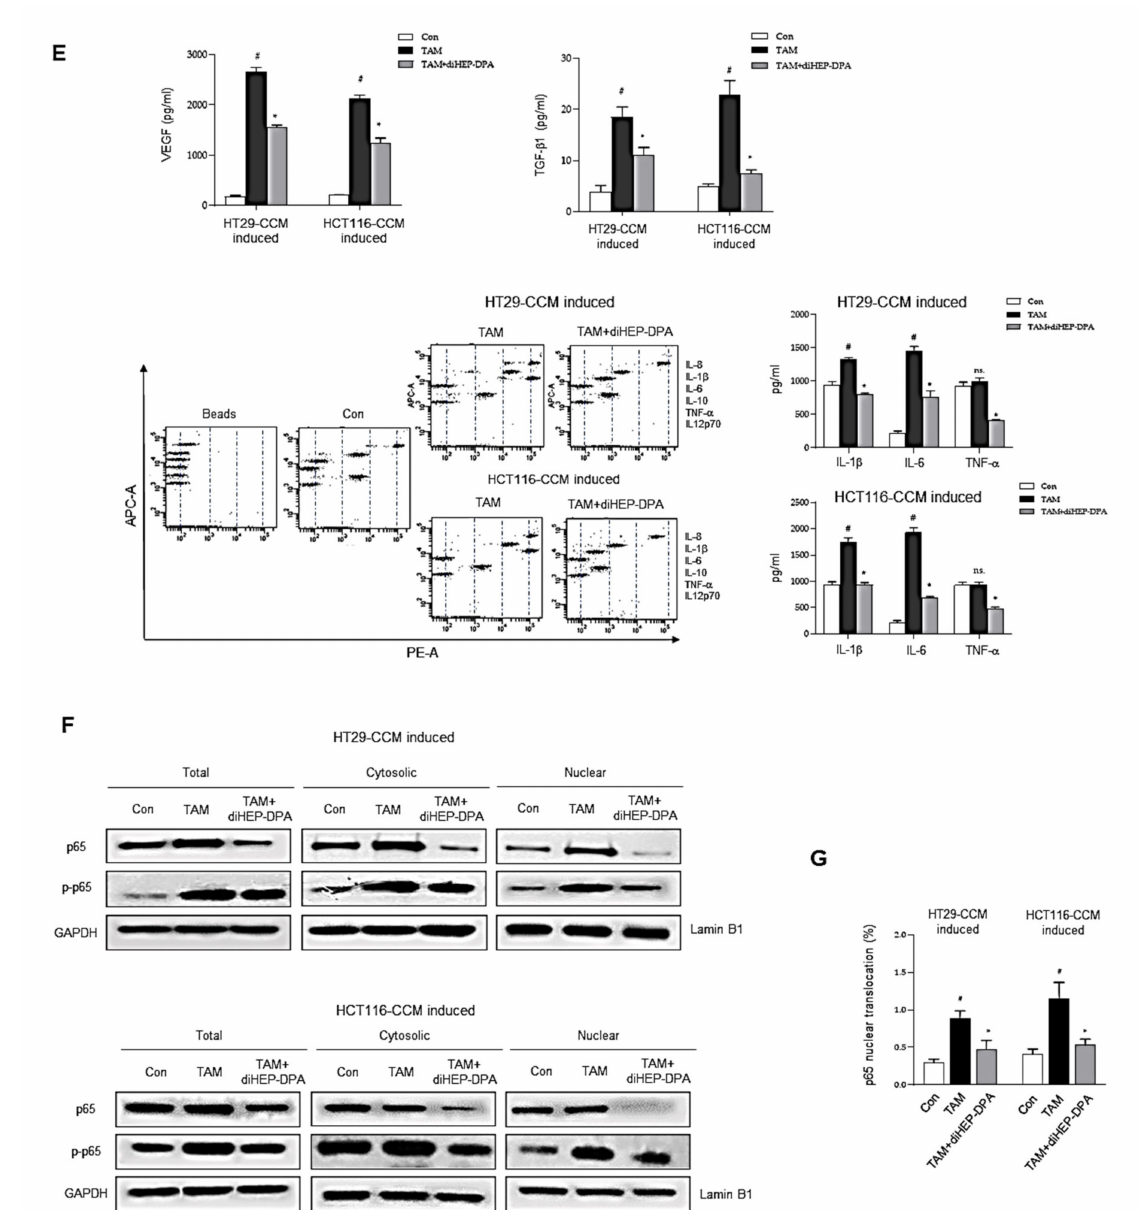
Figure 2. DiHEP-DPA modulates TAM polarization. ( A ) Experimental procedure for inducing TAMs. ( B ) diHEP-DPA– induced morphological changes after 48 h without damage to cell viability. Scale bar: 100 µ m. ( C ) Transcript levels of the TAM markers, CD133, CD206, CD209, MMP2, MMP9, TREM2, and VEGF were determined in diHEP-DPA-treated macrophage using gene-specific primers and quantitative RT-PCR. β -actin was detected as an internal control. ( D ) CD206 and CD163 expression, assessed by Western blotting using antibodies against CD206 and CD163. DiHEP-DPA decreased CD206 and CD163 expression during TAM polarization. ( E ) Cytokine profile assay of conditioned media from TAMs and diHEP-DPA-treated TAMs, performed using a specific ELISA kit for VEGF and TGF- β 1, and cytokine beads. ( F ) NF- κ B activation was assessed in TAMs treated with/without diHEP-DPA using antibodies against p65, p-p65, GAPDH, and lamin B1. DiHEP-DPA decreased protein expression of p65 in both nuclear and cytosolic compartments during TAM polarization. ( G ) Nuclear protein binding assay showing binding of nuclear NF- κ B with DNA in lysates from TAMs treated with diHEP-DPA, determined using an NF- κ B Transcription Factor Assay Kit (Cayman). Data from triplicate experiments are presented as the means ± SD ( # p < 0.05 versus the DMSO-treated control group; * p < 0.05 versus the TAM